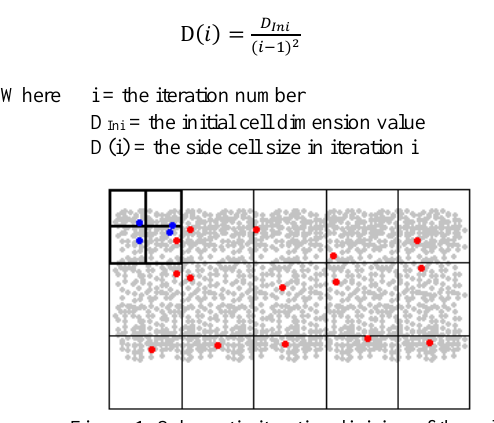
Figure 1. Schematic iterative division of the cells